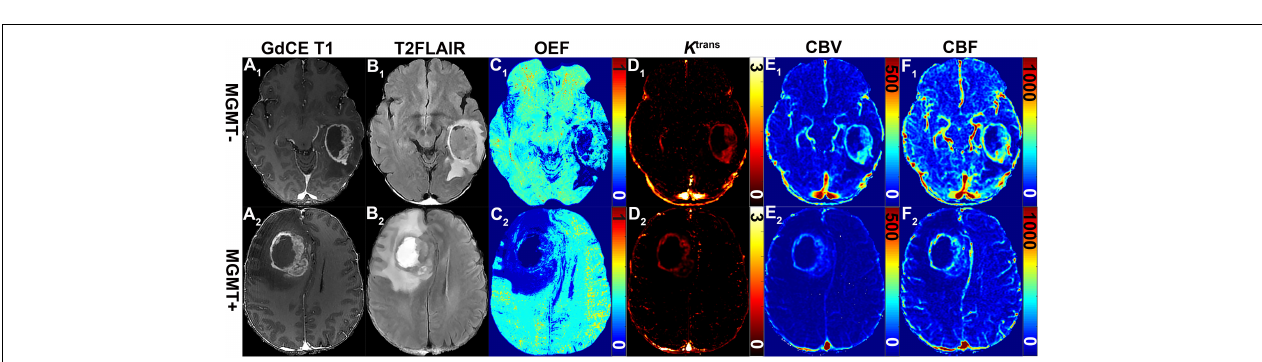
FIGURE 1 | MRI-based OEF and DCE perfusion images in representative glioma patients with and without IDH mutation. Two exemplary patients with IDH1-wt (astrocytoma II; A 1 –F 1 ) and IDH1-mut (astrocytoma II; A 2 –F 2 ) lower-grade glioma shown: (A 1 ) gadolinium contrast-enhanced (GdCE) 3DT1BRAVO, (B 1 ) T2-FLAIR, (C 1 ) QQ-based OEF maps by CAT, DCE-MRI with separated K trans (D 1 ) , CBV (E 1 ) , and CBF (F 1 ) maps. OEF map (C 1 ) allows to delineate significantly inhomogeneous hyperintensity in the contrast-enhanced region of the IDH1 wild-type astrocytoma; DCE-derived maps (D 1 –F 1 ) clearly show the area of hyperperfusion and high permeability in the IDH1 wild-type astrocytoma.